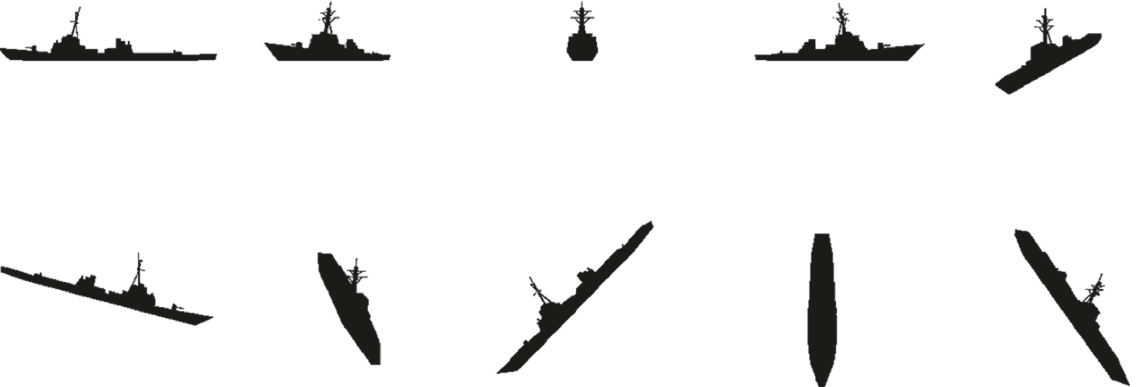
Figure 6: Shape prior database of ship